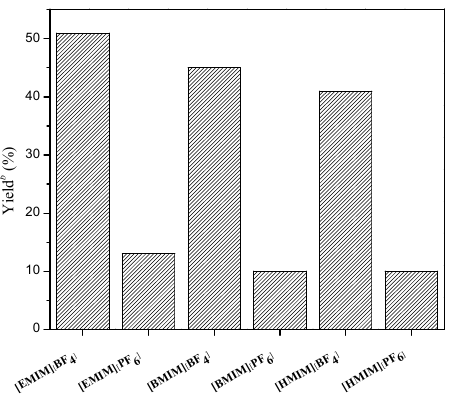
Figure 1. Reaction yields in different IL aqueous solutions a . a Reaction conditions : 2-aminoacetophenone (0.3 mmol), ethyl acetoacetate (0.36 mmol), and α -chymotrypsin (10 mg) in 50% (H 2 O/(IL + H 2 O), v / v ) IL aqueous solution at 60 °C for 24 h. b Isolated yield after column chromatography.